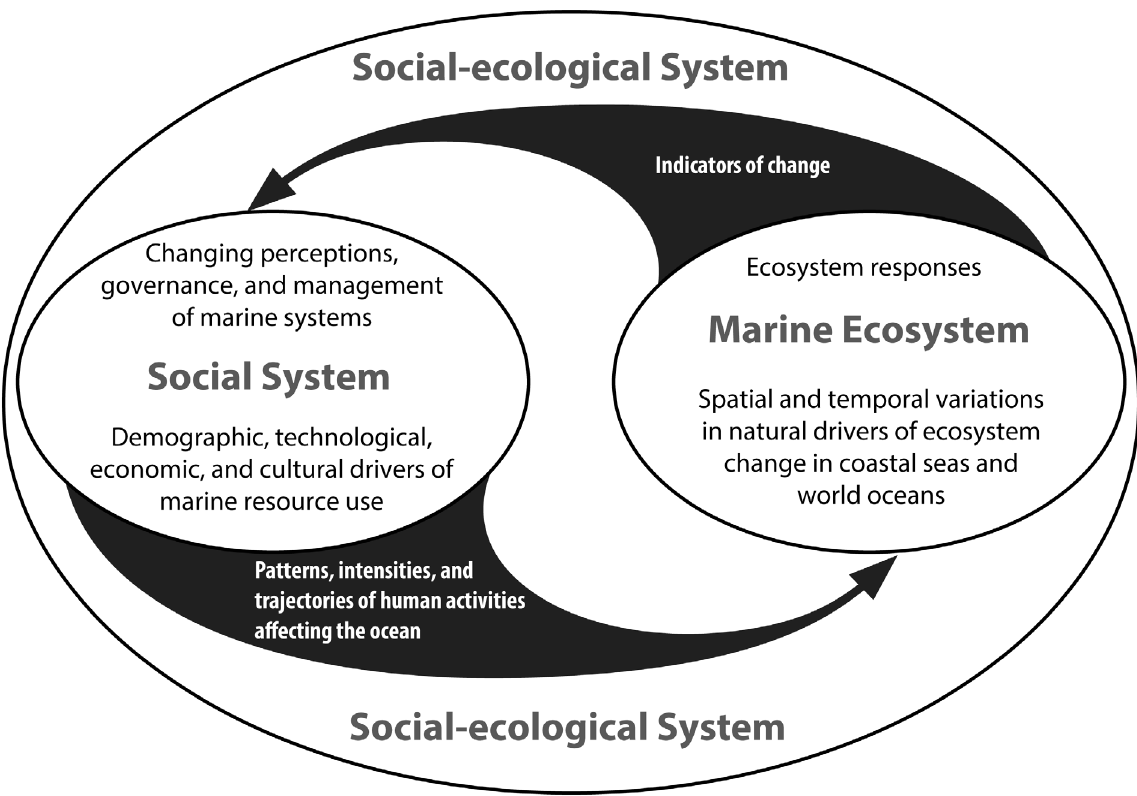
Figure 1. Integrated view of the global history of human interactions with life in the oceans.